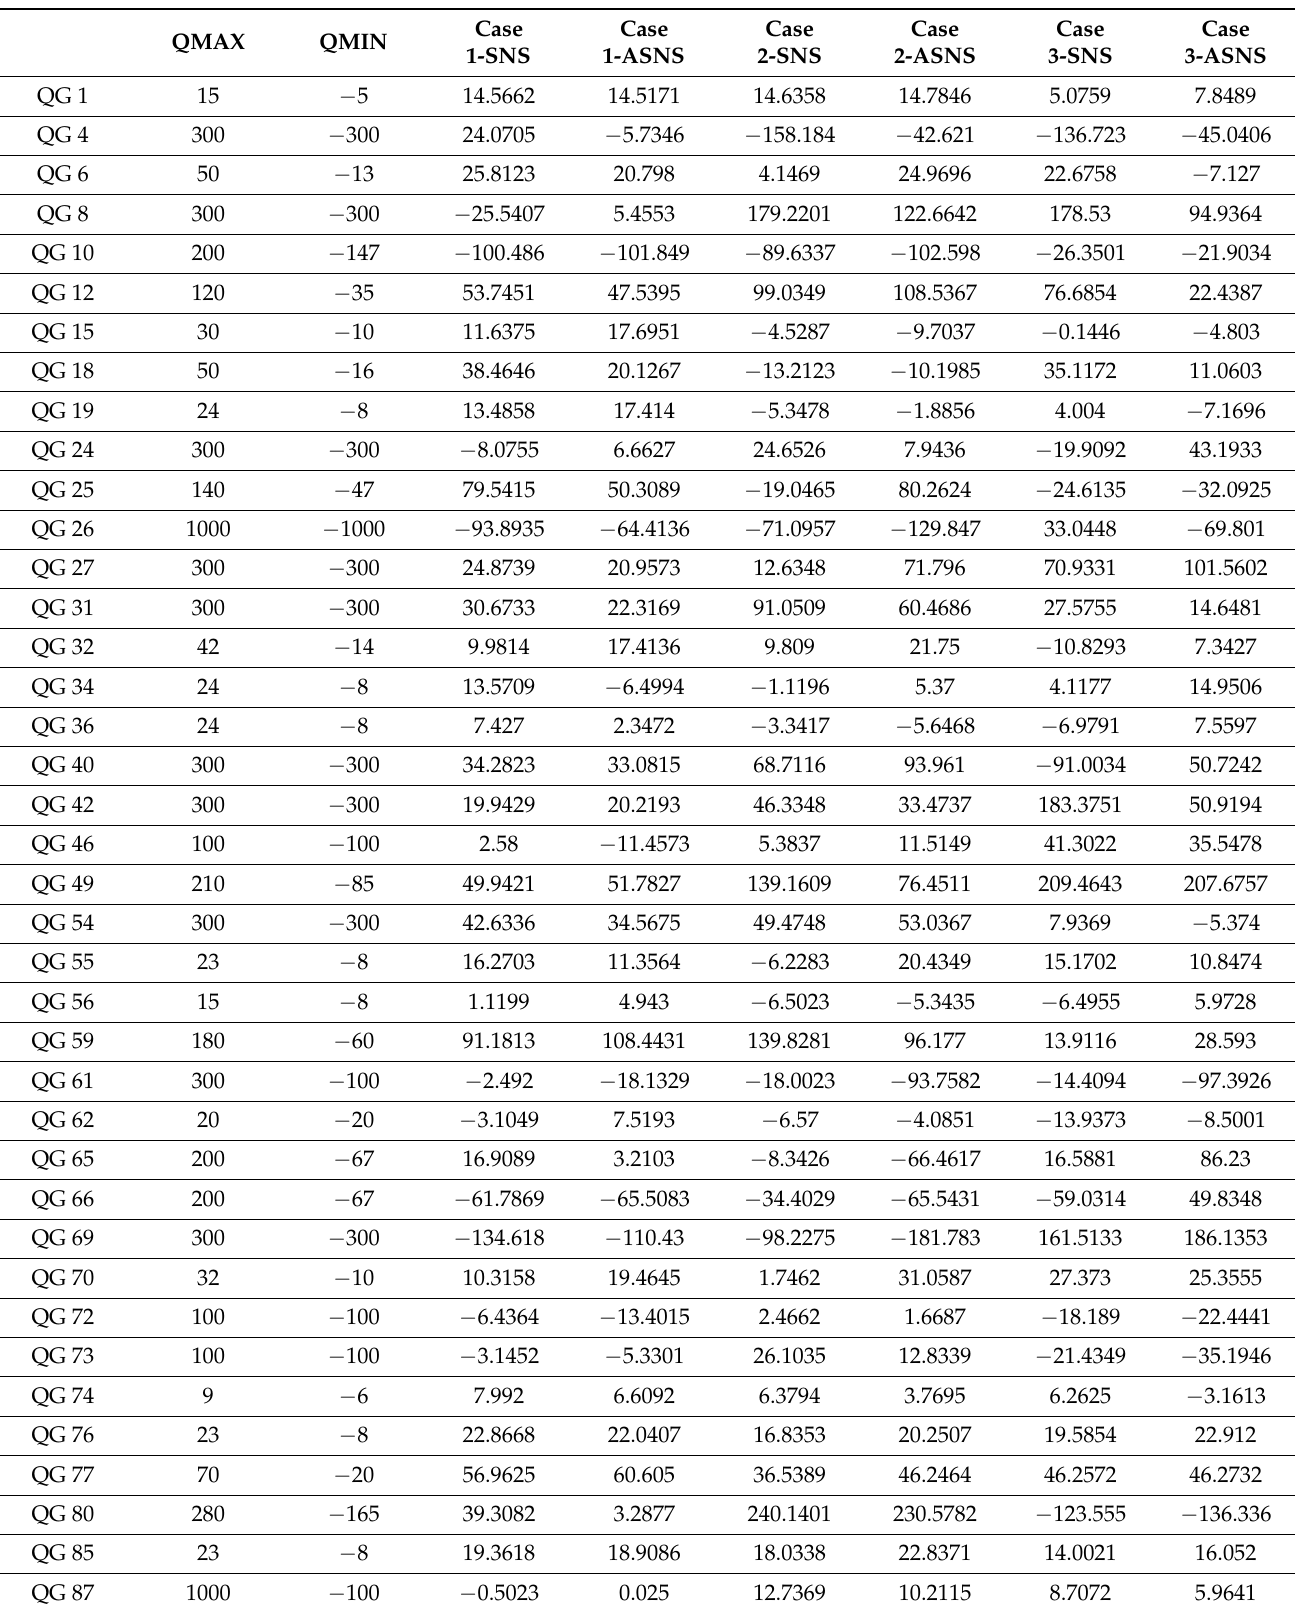
Table A4. Generators’ reactive power for the IEEE 118-bus